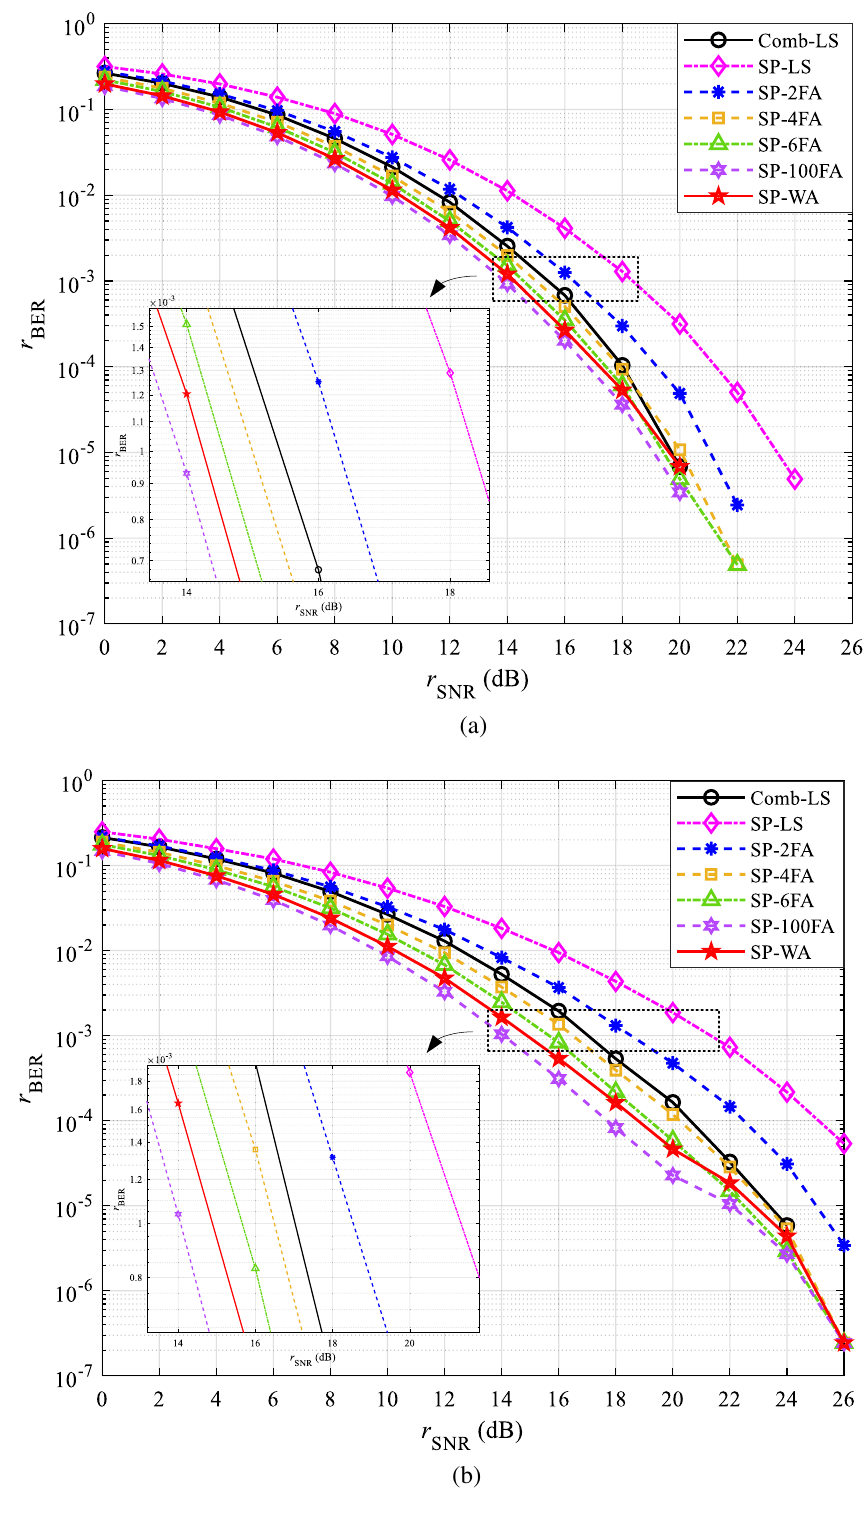
Figure 7. The BER performance in CDT 1 channel: ( a ) QPSK and ( b )